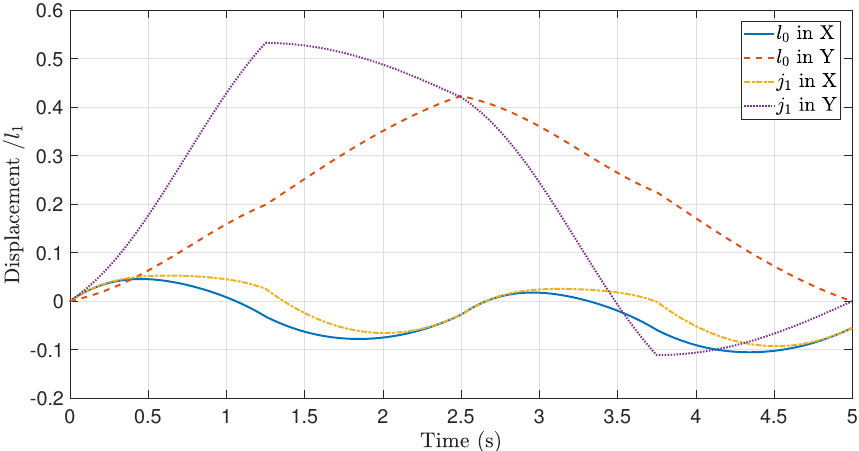
Figure 4. Normalized displacement of the central link ( l 0 ) and left joint ( j 1 ) of the Purcell’s three-link swimmer in X and Y axis, implementing a square gait with π /3 as its amplitude, η = 1/2, l 0 = 2 and l = 4. The results match those presented in